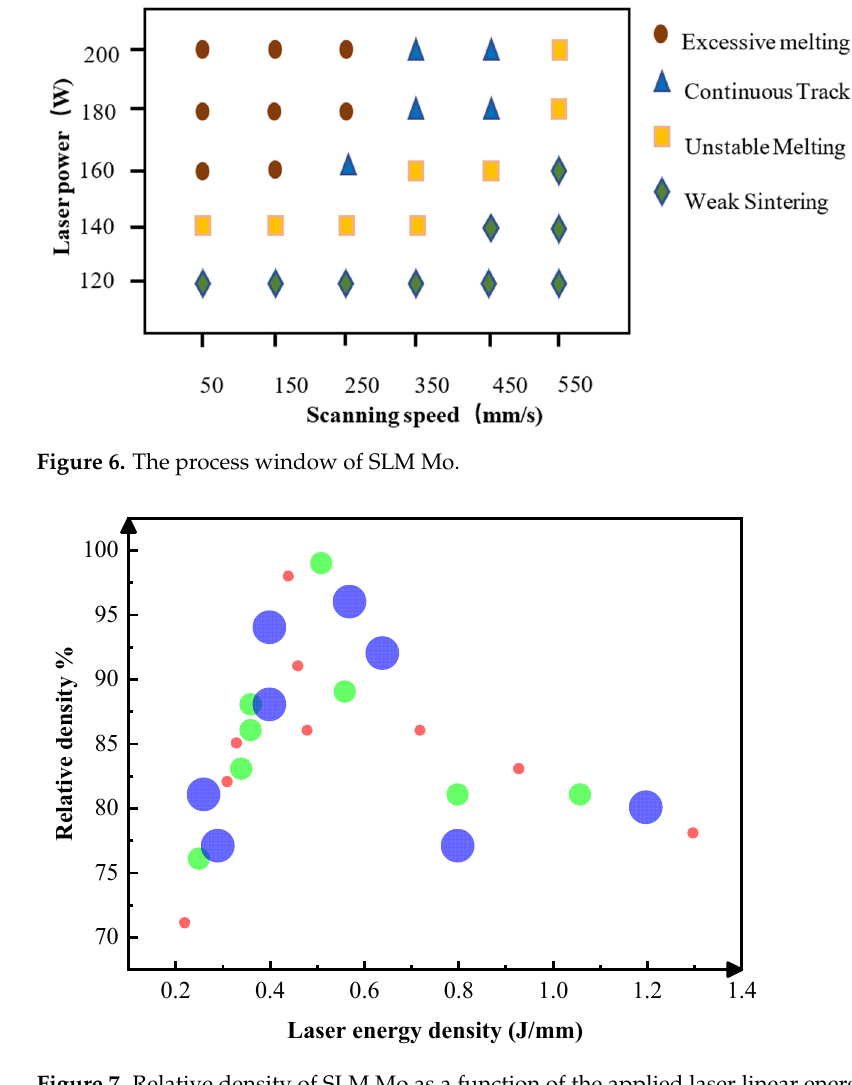
Figure 7. Relative density of SLM Mo as a function of the applied laser linear energy.